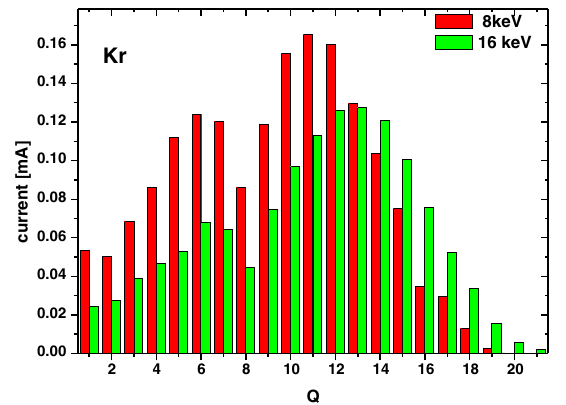
FIG. 1. Charge state distribution of the extracted krypton ions for the electron temperatures of 8 and 16 keV.